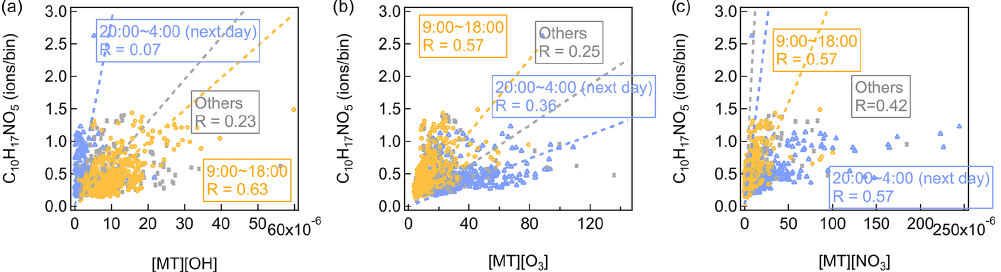
Figure 14. Scatter plots of C 10 H 17 NO 5 versus the product of (a) [OH] × [monoterpenes], (b) [O 3 ] × [monoterpenes], and